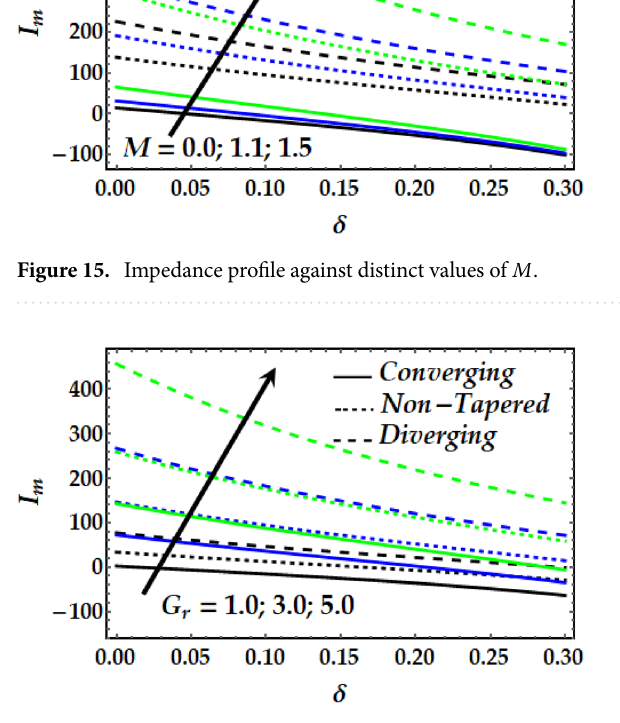
Figure 16. Impedance profile against distinct values of G r .